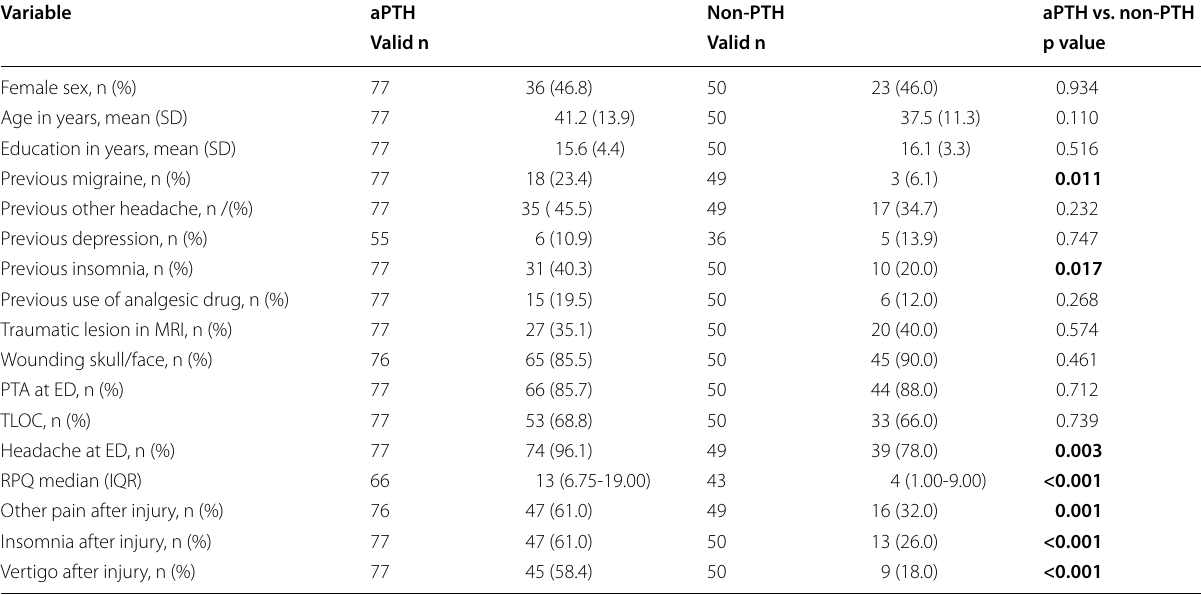
Table 1 Patient demographics in aPTH and non-PTH patients one month after injury